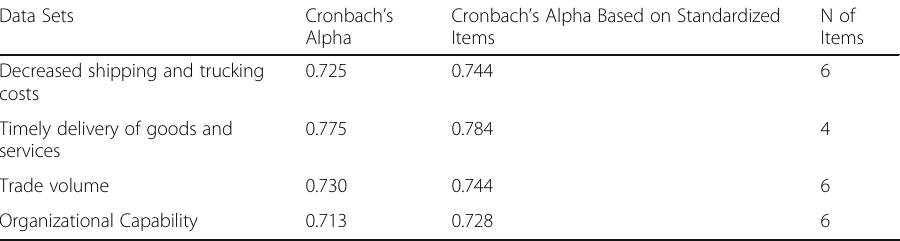
Table 6 Reliability Statistics Results